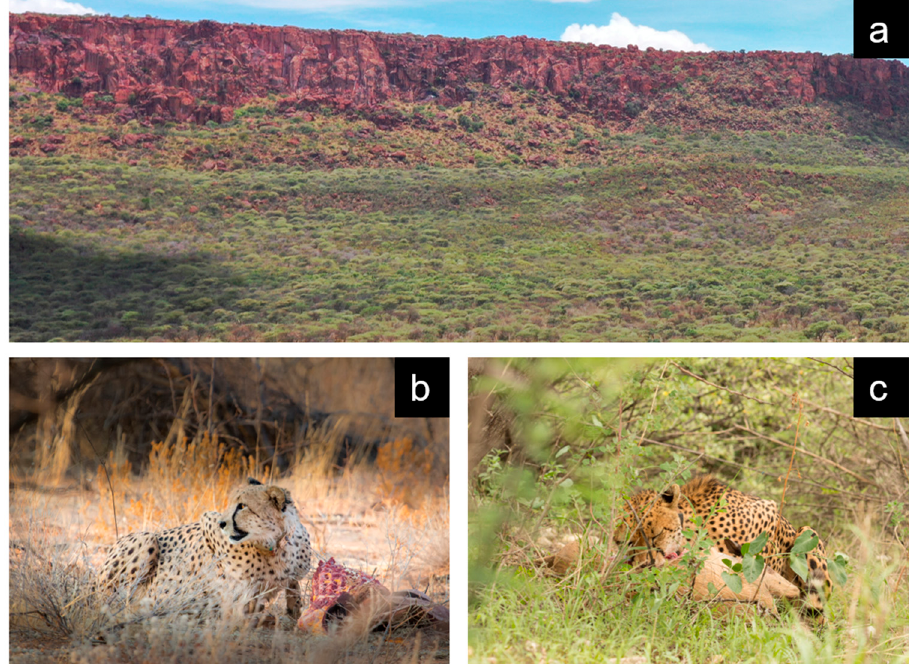
Figure 3. Bush encroachment affects various stages of predation, such as by impacting hunting efficiency and prey accessibility ( a ). Open areas are important for cursorial predators to detect and subdue prey and bush encroachment may affect capture success ( b ). Kleptoparasitism can decrease in bush-encroached areas, but in such areas, subordinate predators can be at greater risk of encountering dominant ambush predators ( c ). Photos by the Cheetah Conservation Fund.